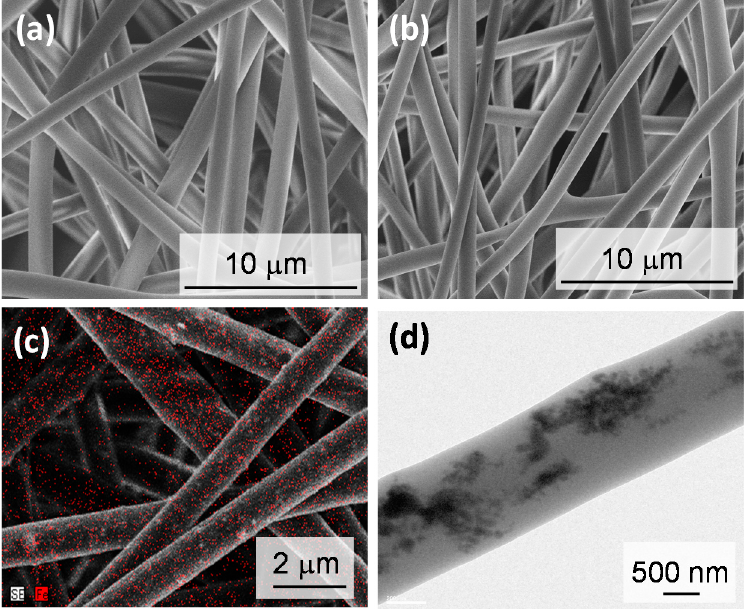
Figure 3. Scanning electron microscope (SEM) images of the fiber mesh before ( a ) and after ( b ) thermal crosslinking. ( c ) energy dispersive X-ray spectroscopy (EDX) image and ( d ) transmission electron microscope (TEM) image of MNP-loaded fibers (red: Fe element).